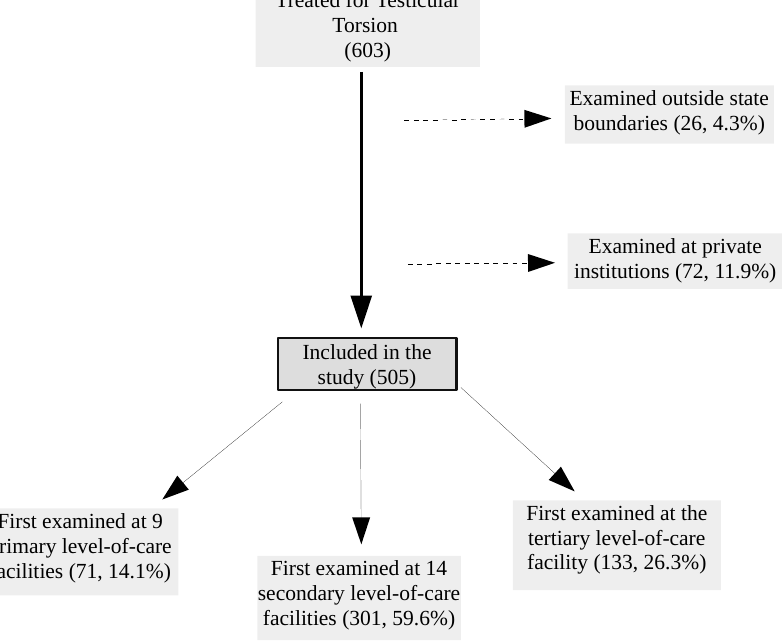
Figure 1 - Distribution of patients according to the first examining facility